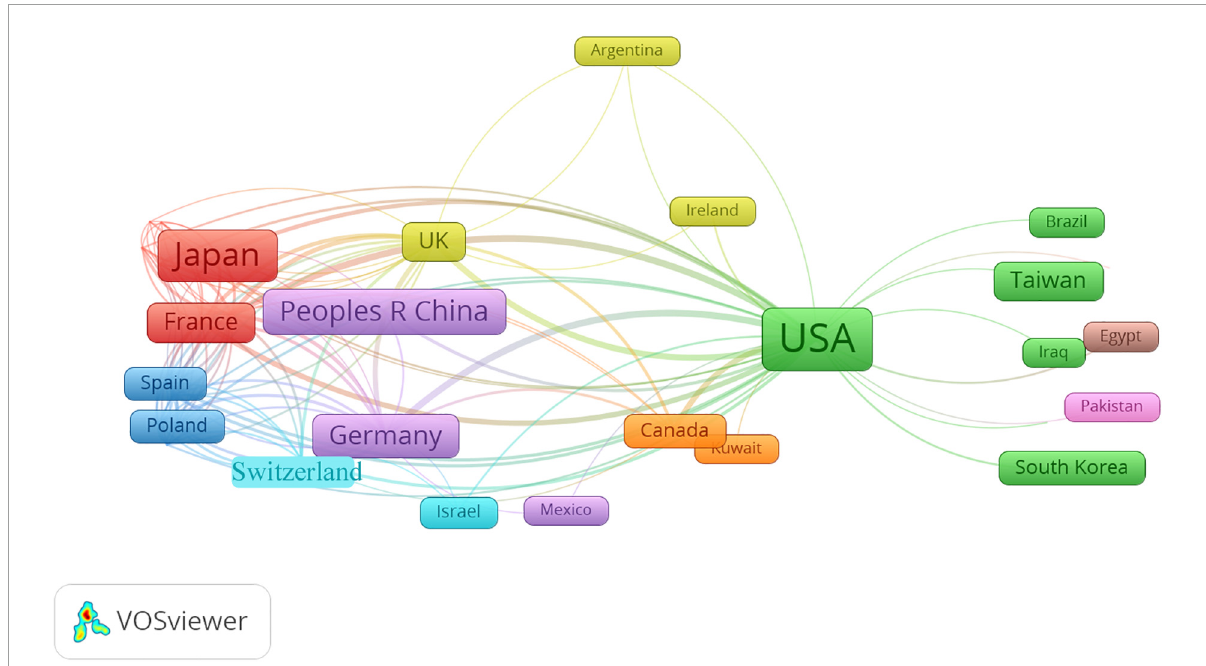
FIGURE4 Network visualization map of country co-authorships. Thicker lines indicate stronger collaborations. Countries represented with larger circle size or font size had relatively more publications.